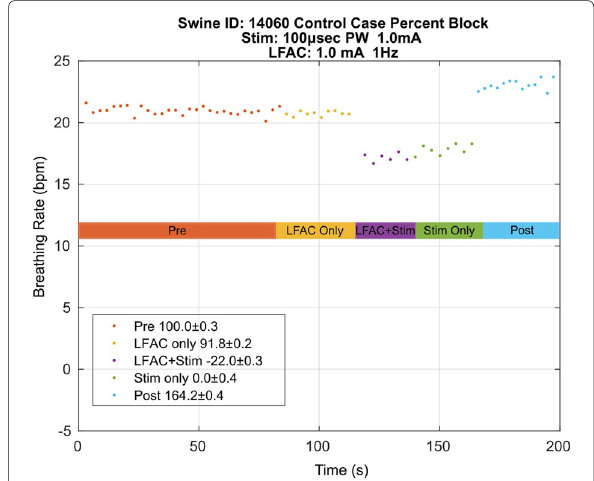
experiments. The average percent block achieved dur- ing ‘LFAC+Stim’ was 87.2 ± 8.8%. In contrast, the control cases averaged 9.3 ± 24% block during ‘LFAC+Stim’. A negative percent block indicates that the BRrate during ‘LFAC+Stim’ was lower than that of the BRrate in the ‘Stim Only’ epoch.